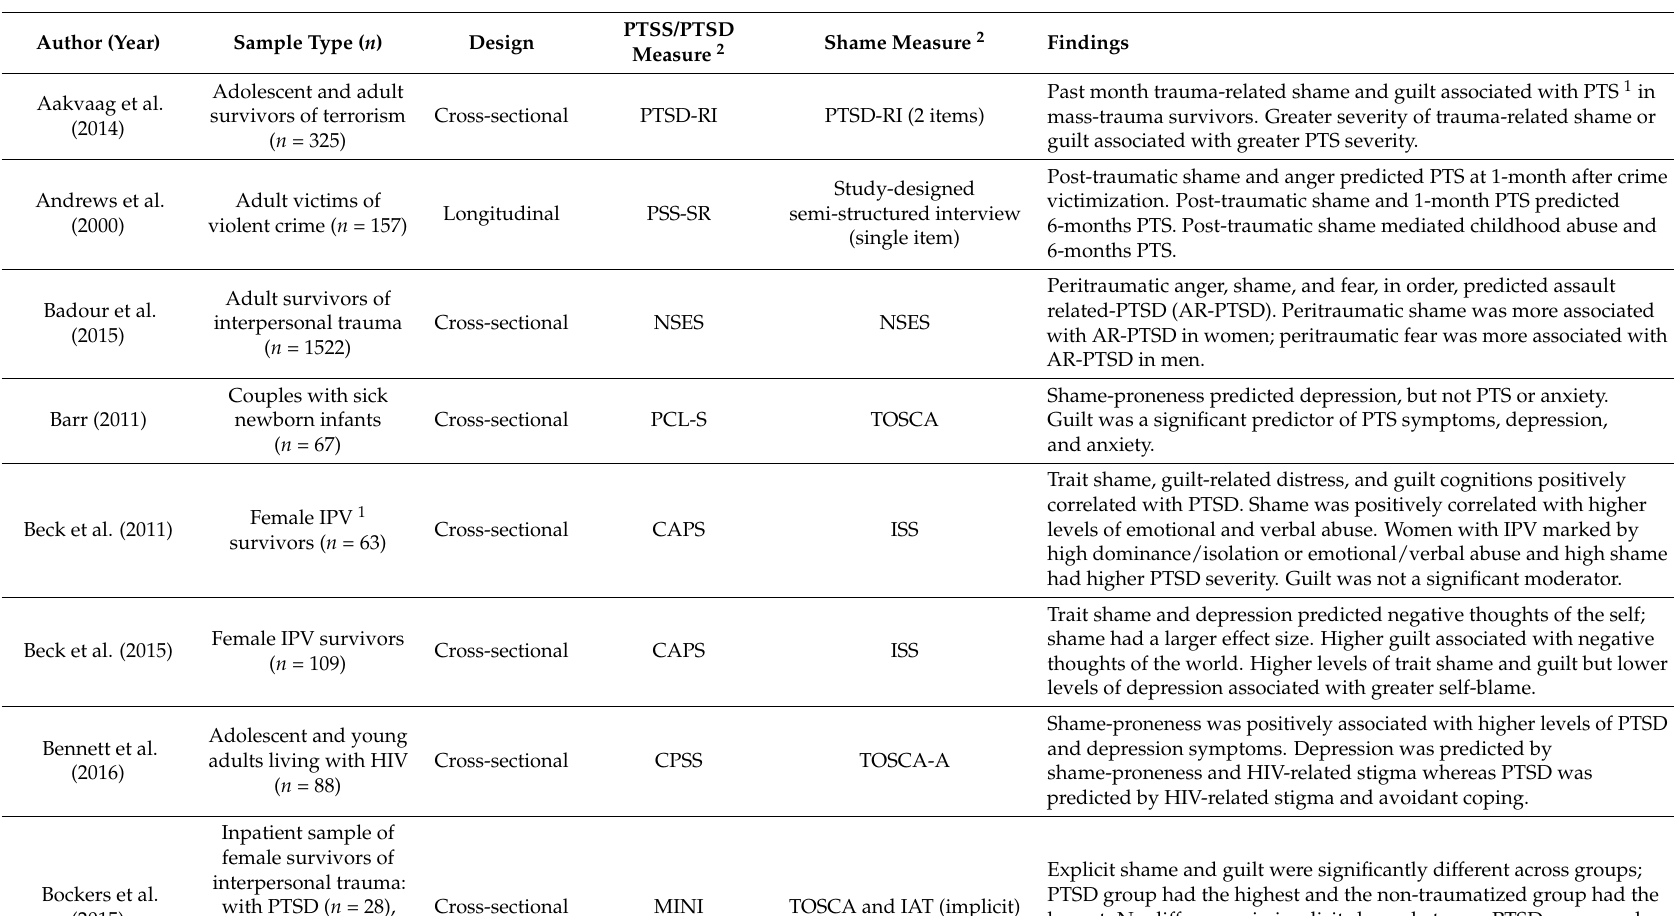
Table 1. Characteristics and key findings of reviewed